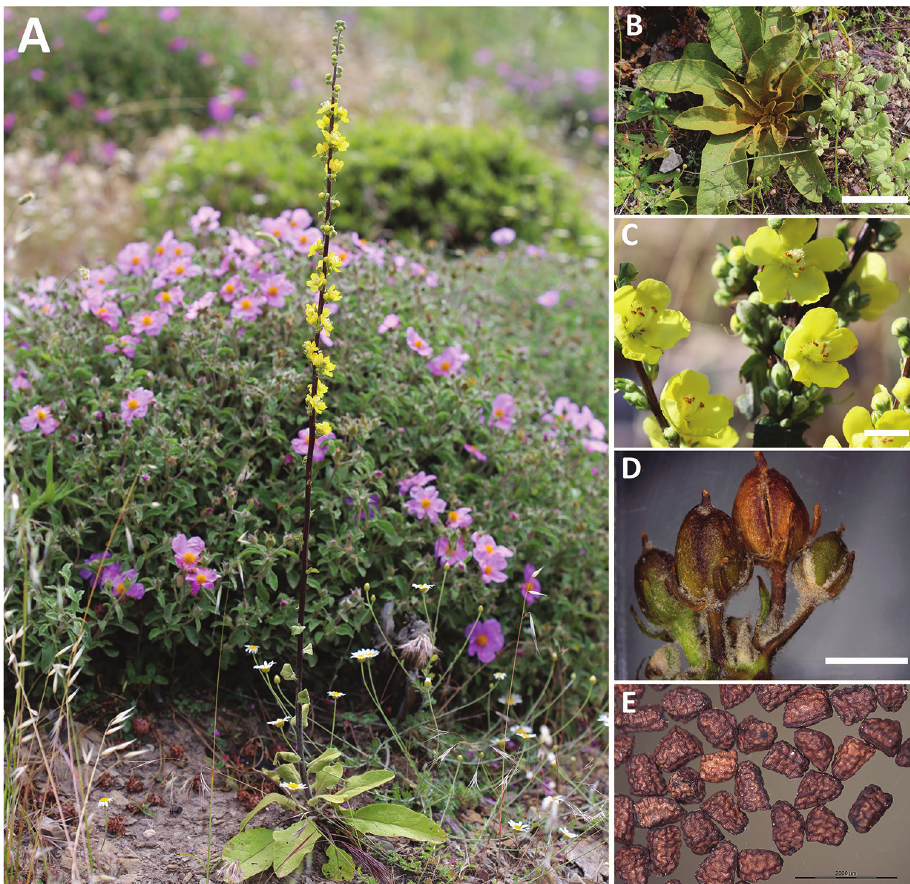
Figure 1. Verbascum delphicum subsp. cervi Zografidis: A habit B first year mature leaf-rosette, bar = 10 cm C partial inflorescence, bar = 1 cm D capsules, bar = 5 mm D seeds, bar = 2